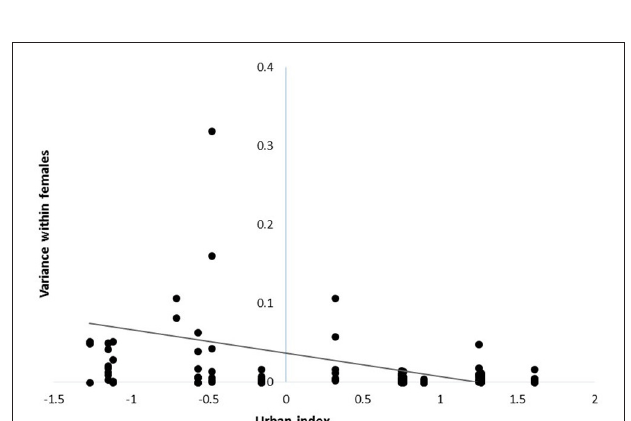
FIGURE 2 | Within-individual variance in reproductive contributions for female cardinals across years at sites distributed along a rural-to-urban landscape gradient in Ohio, USA from 2004 - 2014. Each point represents the variance within an individual across